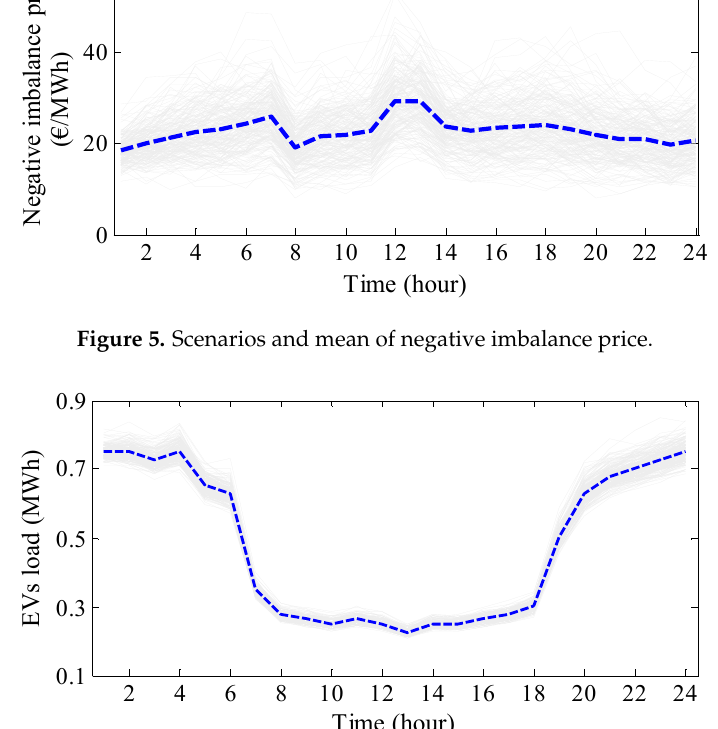
Figure 6. Scenarios of Electric vehcles’ demand.